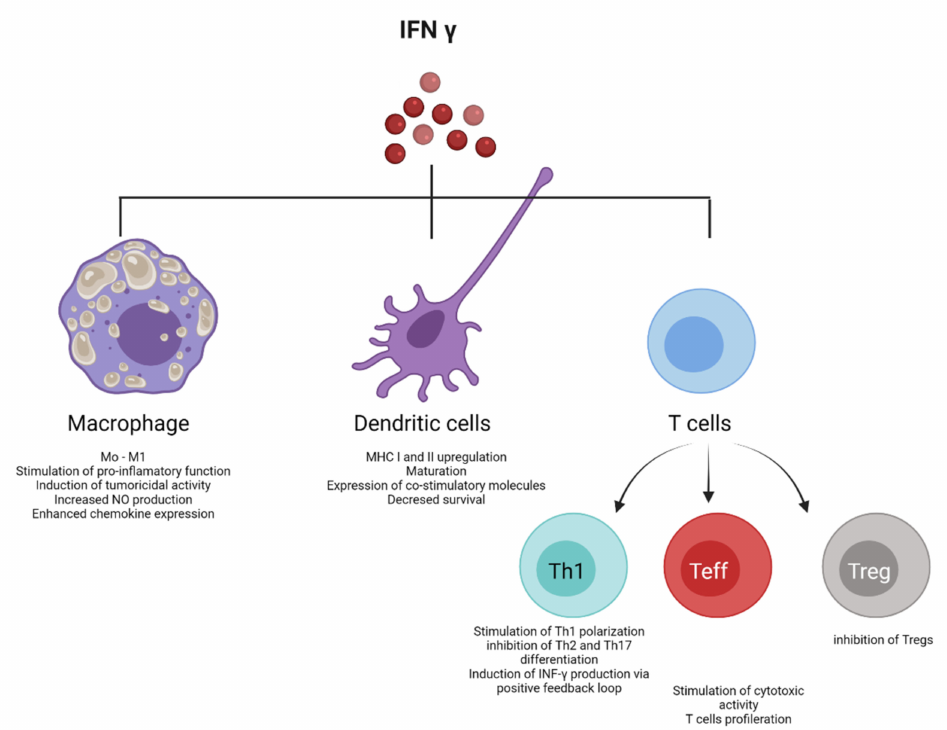
Figure 6. Role of IFN- γ in the antiproliferative response. Interferon- γ interacts with various cells in a tumor microenviron- ment to initiate the production of the cytokine itself. Some of these cells are T lymphocytes, macrophages, and dendritic